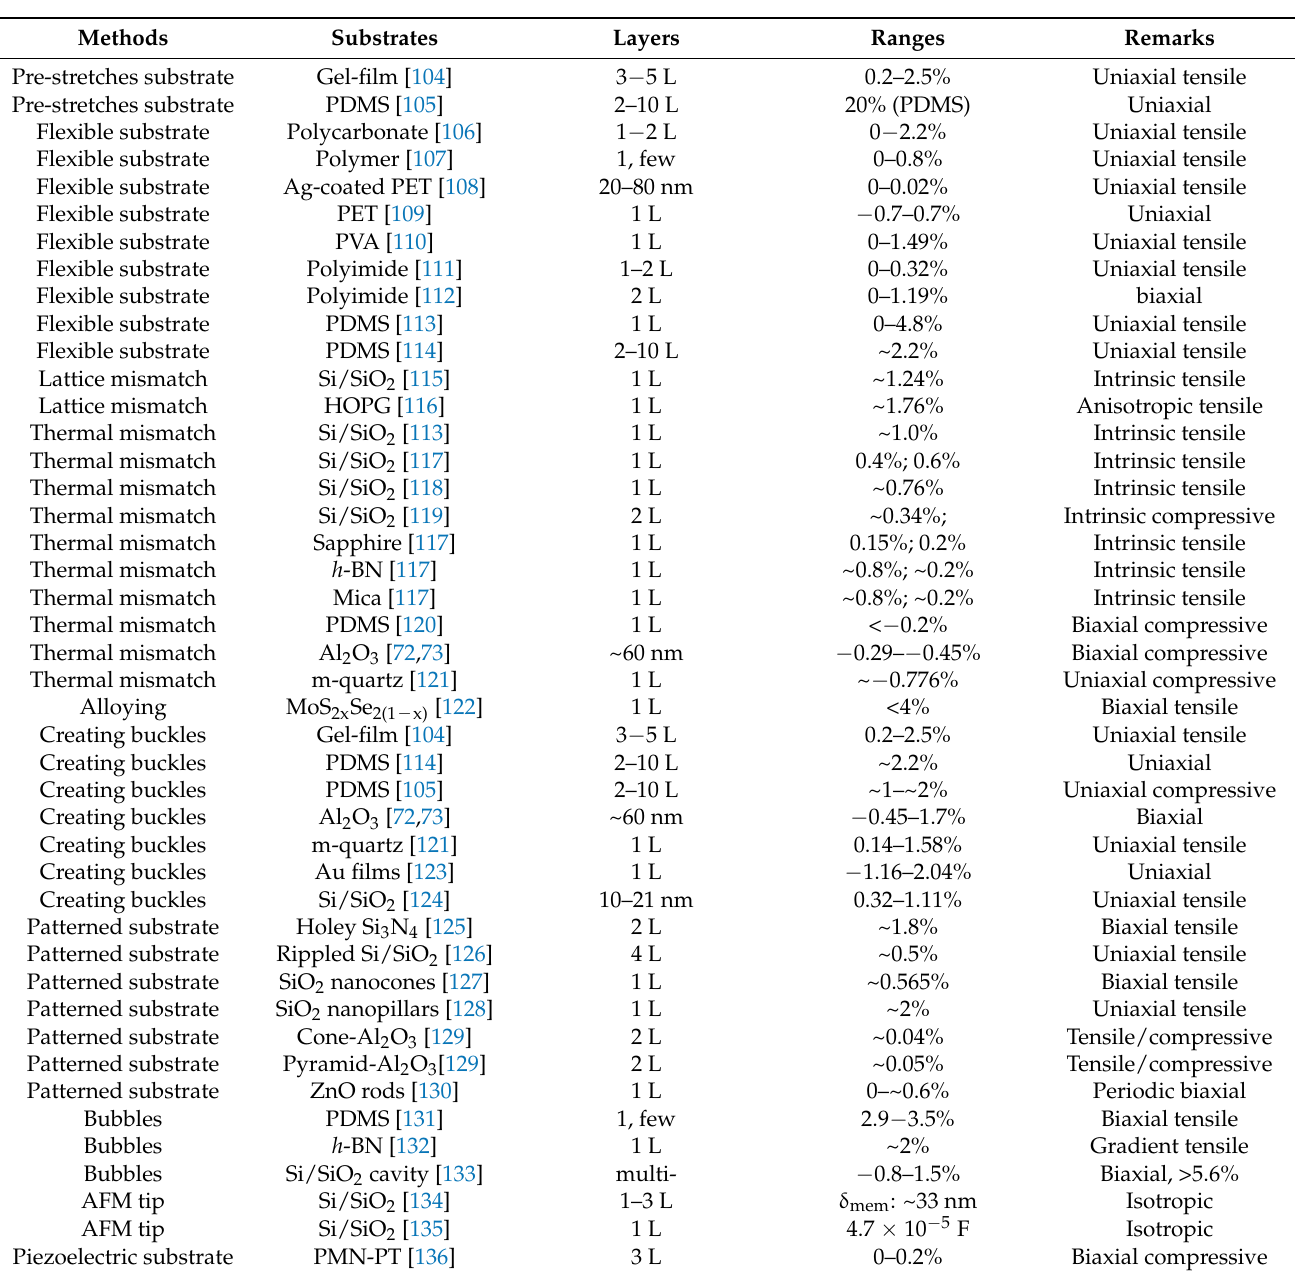
Table 3. The range and types in strained MoS 2 systems by different inducing methods. HOPG: